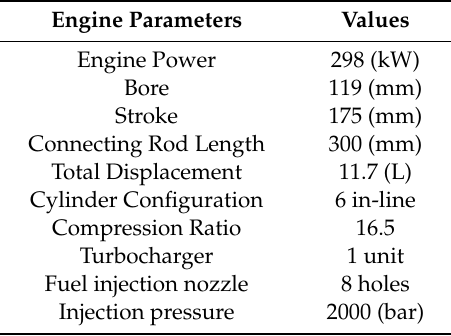
Table 1. Engine parameters.